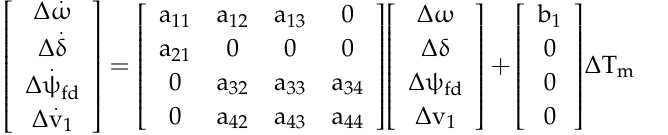
8 of 17 Figure 3. Response diagram of the system fluctuating between stability and